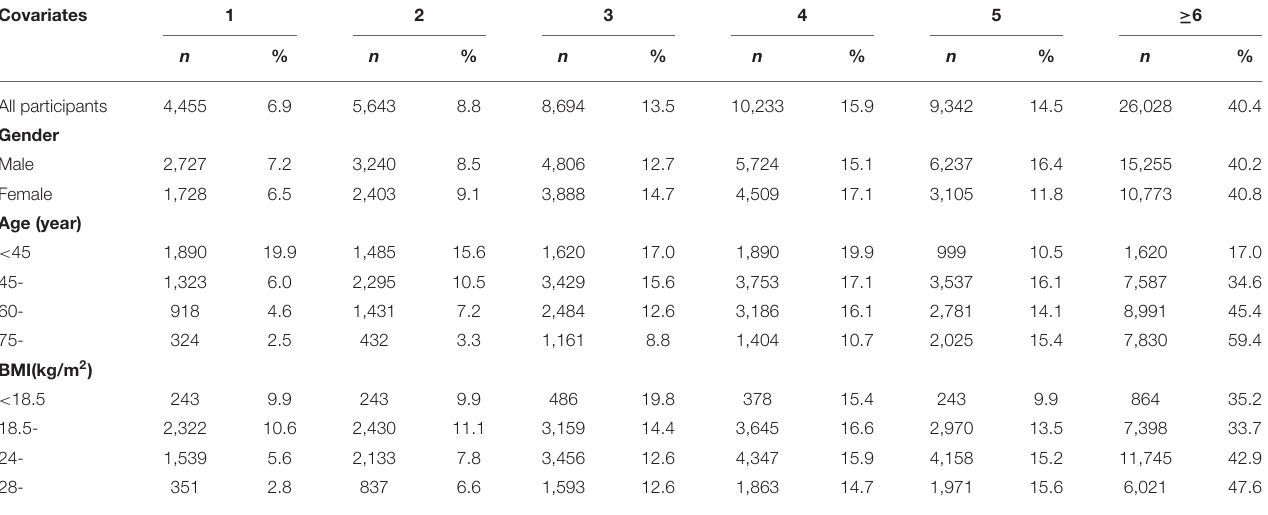
TABLE 3 | Clinical epidemiological characteristics of multimorbidity across groups with different gender, age and BMI.